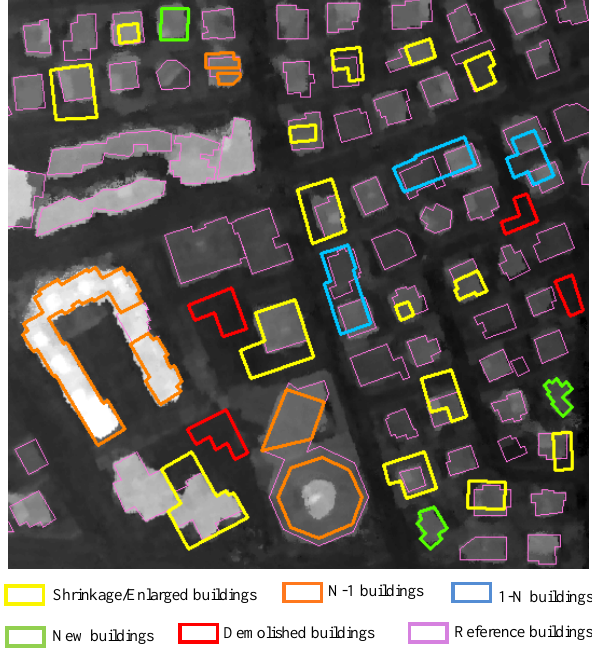
Figure 8. Simulated outdated map and reference building polygons upon the